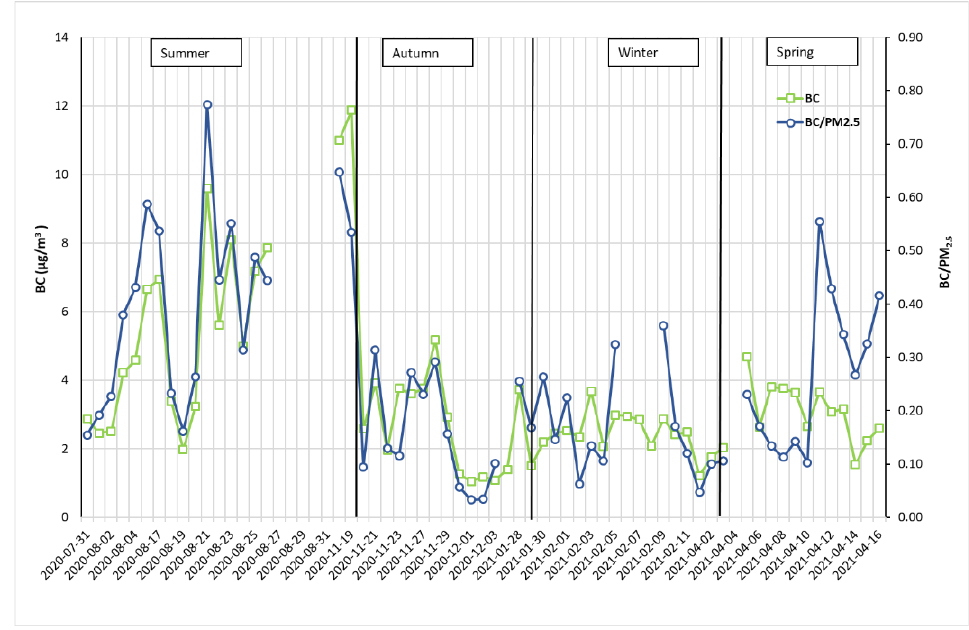
Figure 5. Temporal variations of ambient BC concentrations (µg/m 3 ) and BC/PM 2.5 ratios subdivided into seasons in Kenitra during the study period (2020 – 2021).